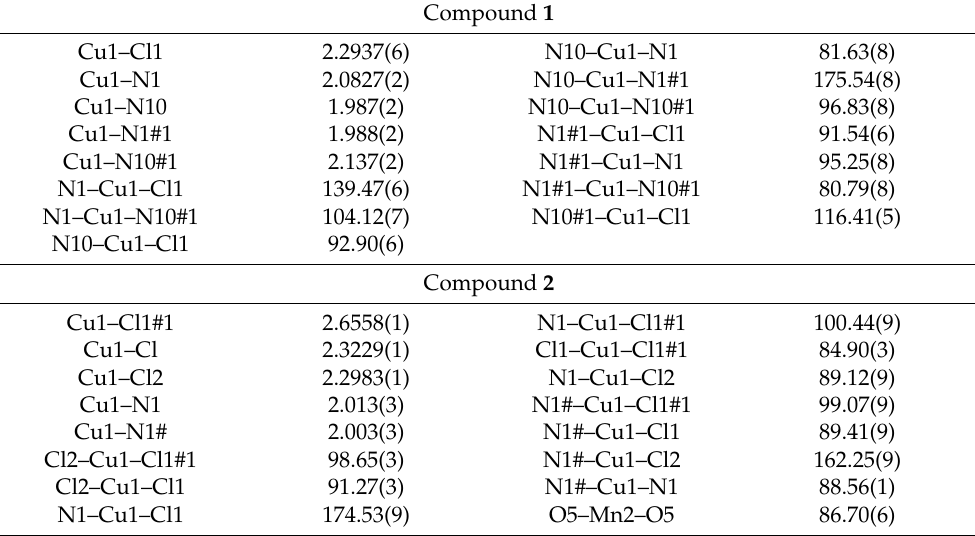
Table 2. Selected bond lengths (Å) and bond angles ( ◦ ) of the Cu(II) centers in compounds 1 and 2